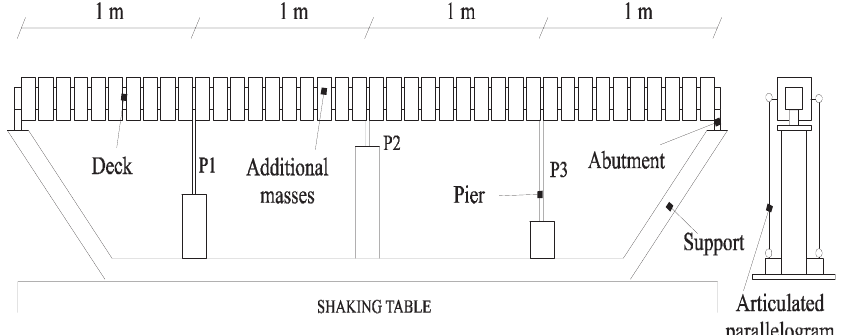
Fig. 1. Elevation of the experimental model.